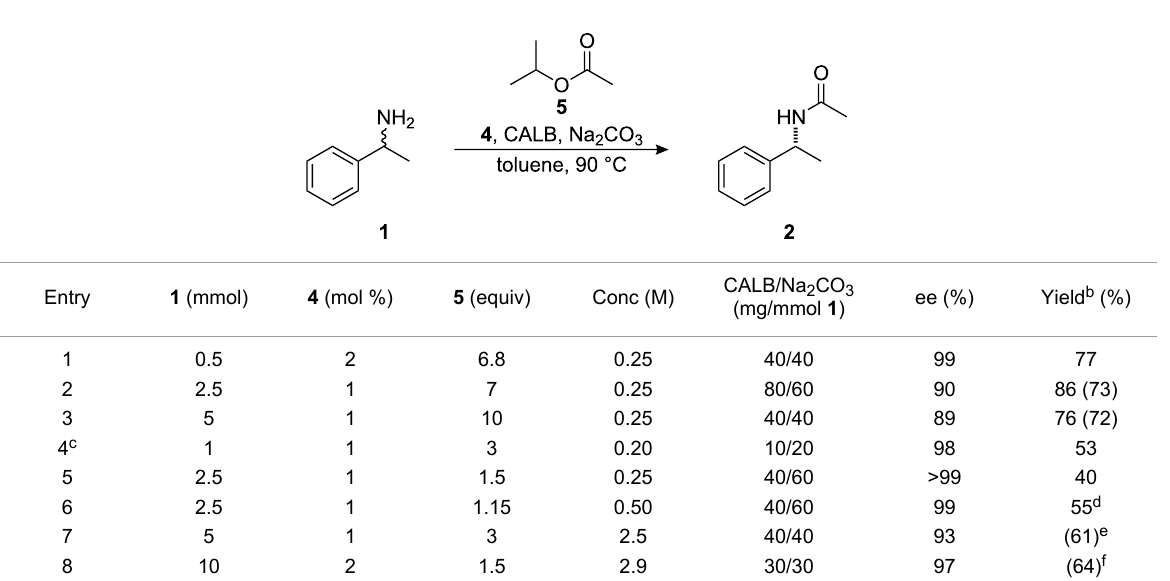
Table 2: Investigation of concurrent changes of DKR parameters with 5 as acyl donor.